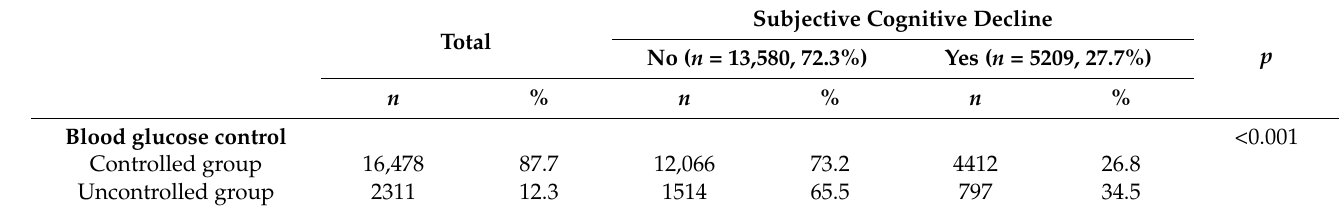
Table 2. Study participants stratified by subjective cognitive decline and blood glucose control ( N =